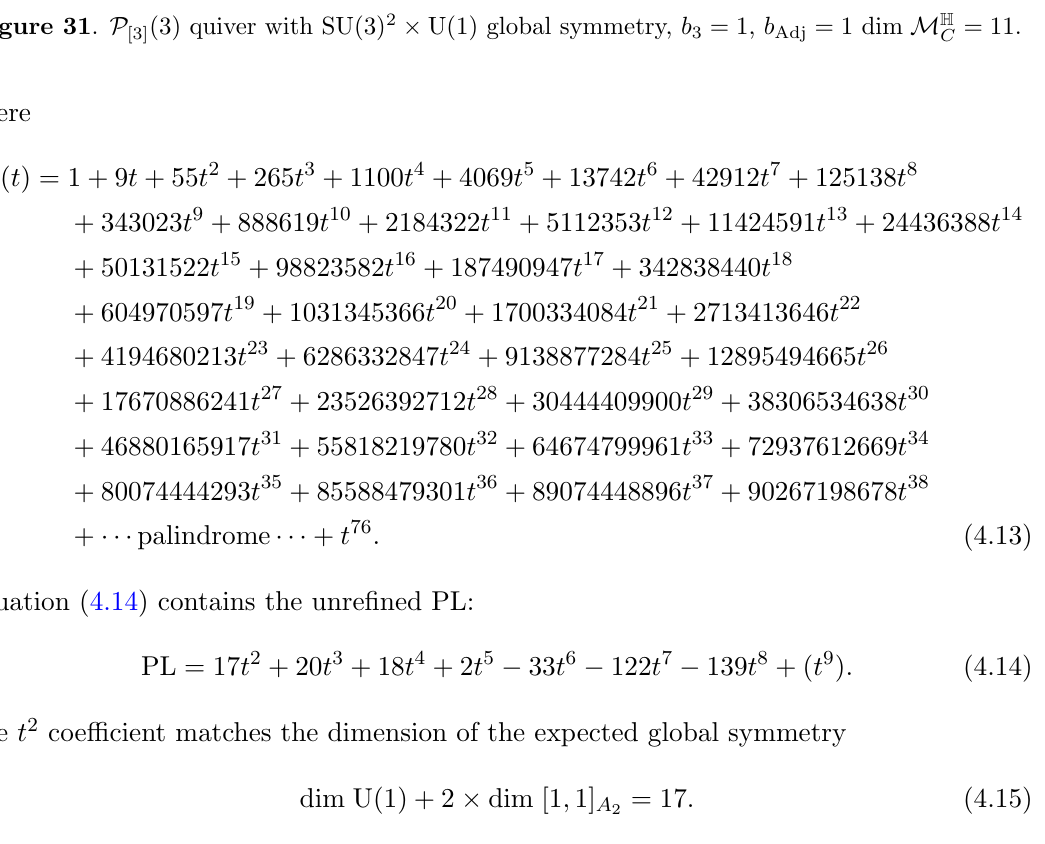
(3) quiver with SU(3) 2 (cid:2) U(1) global symmetry, b 3 = 1, b Adj = 1 dim M H